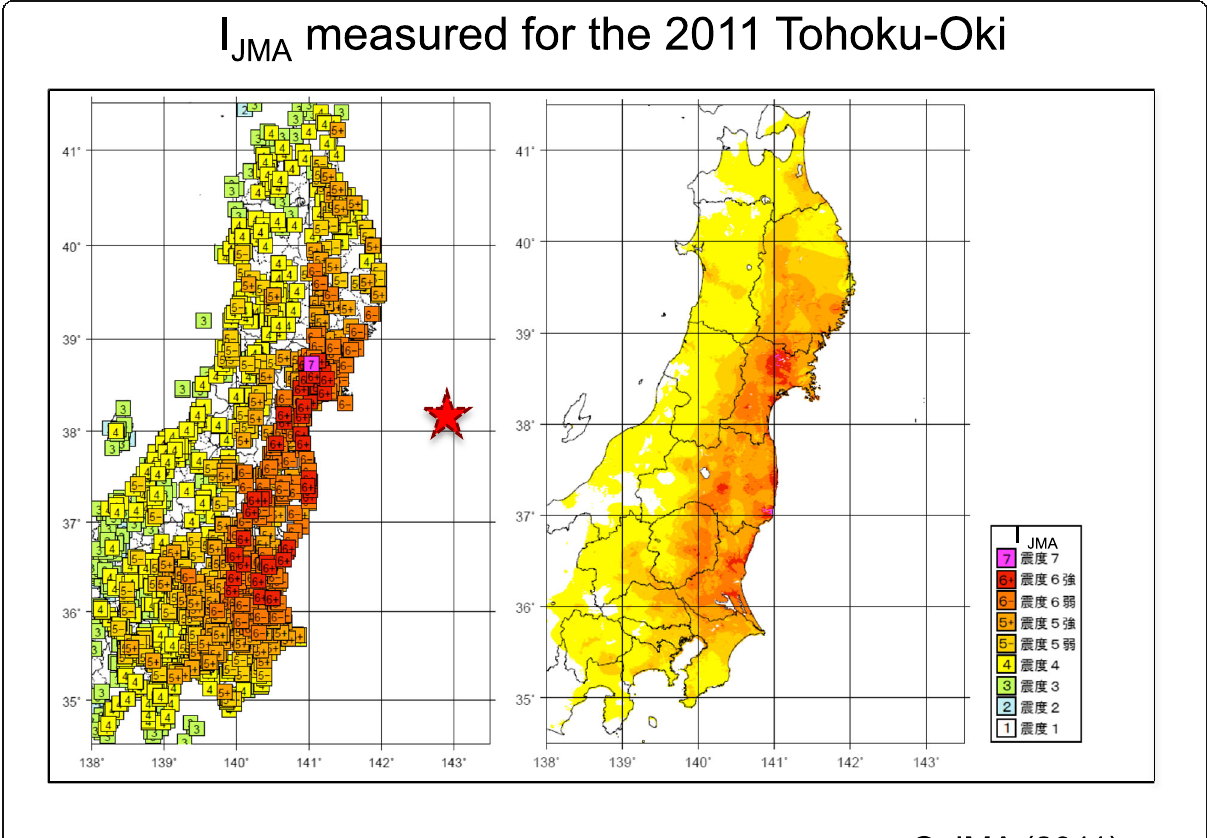
Fig. 8 Observed intensity distribution for the 2011 Tohoku-Oki (Mw9). Intensities from 3 to 7 ( I JMA ) measured by instruments are shown at seismic stations (left) and the estimated distribution of intensities by contours (right) (the figures were downloaded from: http://www.data.jma.go.jp/svd/ eqev/data/2011_03_11_tohoku/index.html). The intensity scale is color coded from 1 (white) to 7 (pink), and the red star shows the epicenter. The region with I JMA 6 − and greater has a stretch of over a few hundred kilometers along the Pacific